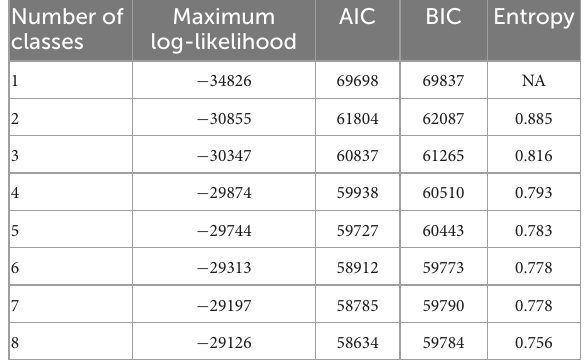
TABLE 4 Fit statistics for latent class models from two to eight classes.